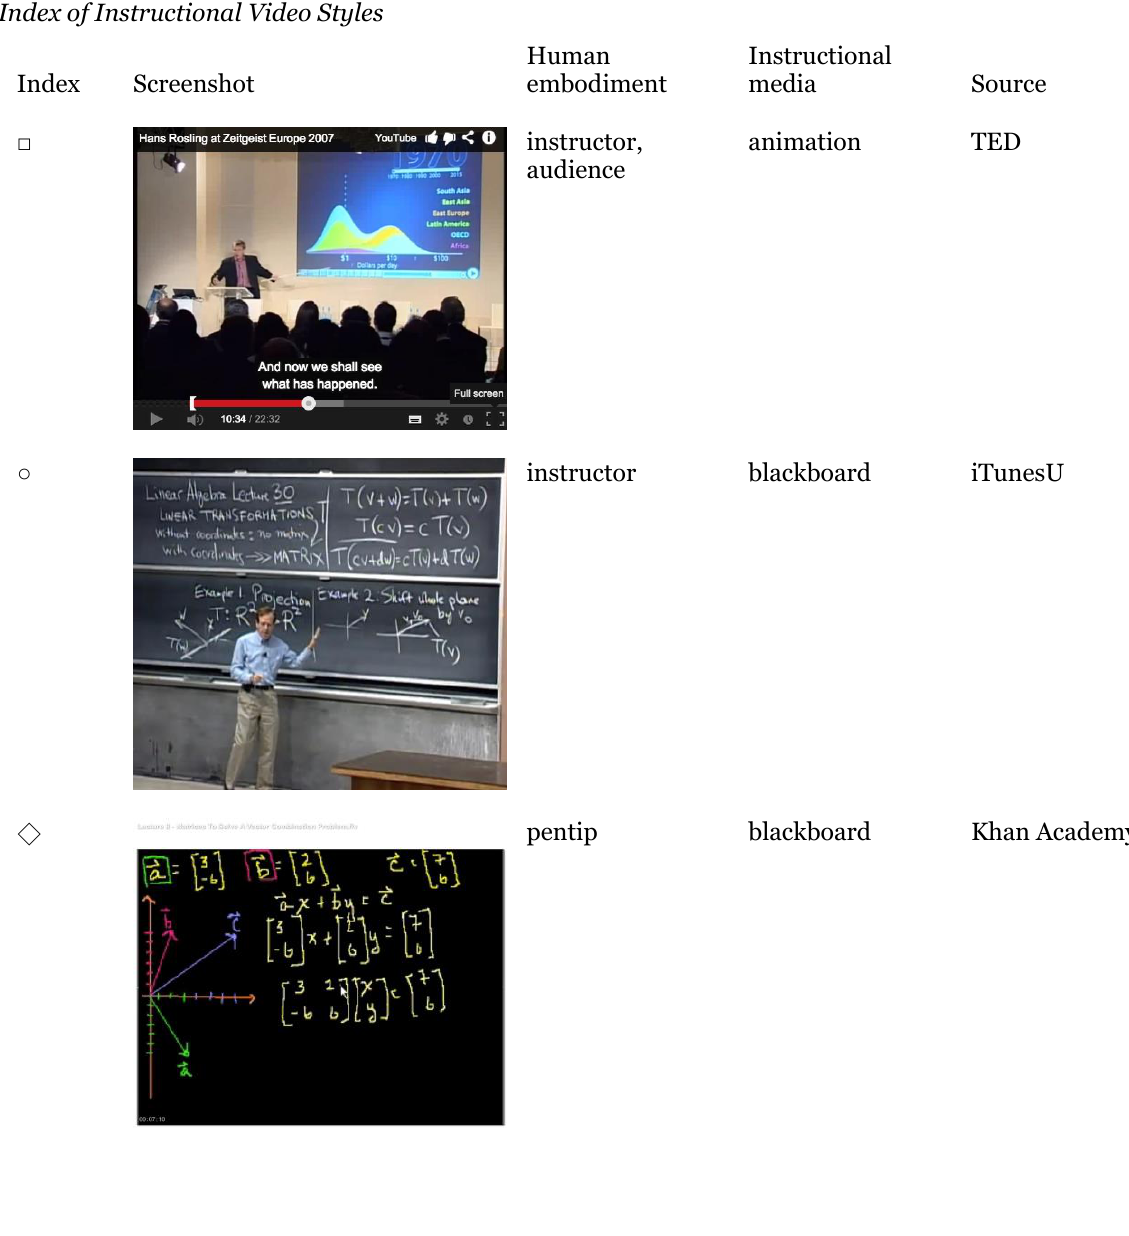
Index of Instructional Video